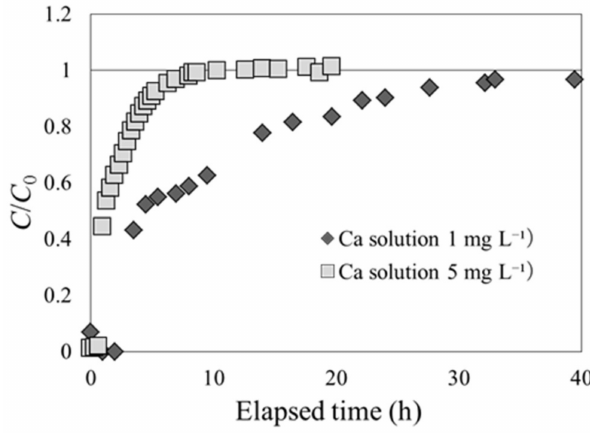
Figure 8. Ca adsorption breakthrough curves for beech sawdust, using Ca solutions with different Ca concentrations (experiment